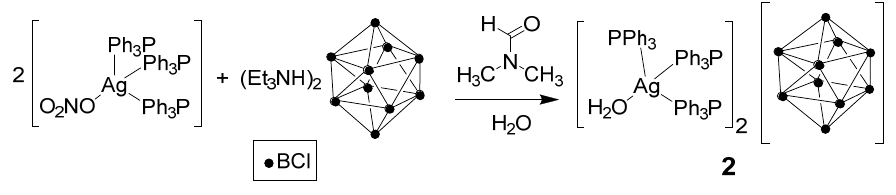
( b ) Figure 1. Molecular view of ( a ) complex 1 · 2DMF and ( b ) 2 · 4DMF in representation of atoms with thermal ellipsoids ( p = 50%). For both solids only half of the anion is symmetrically independent.